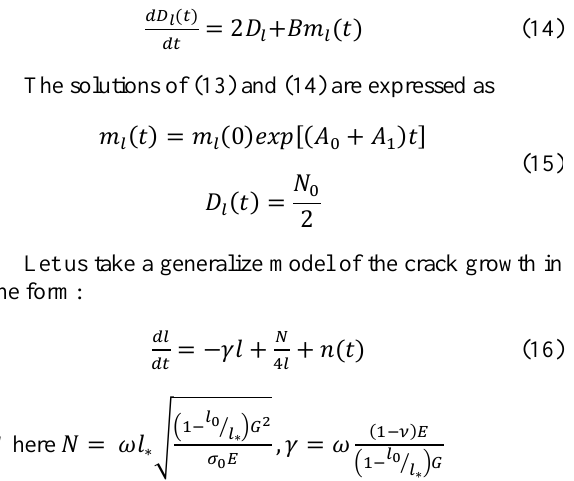
Fig. 2. Curves describing the relationships between at the given roughness and layer thickness. 1. 𝑙𝑙 ∗ 𝜎𝜎⁄